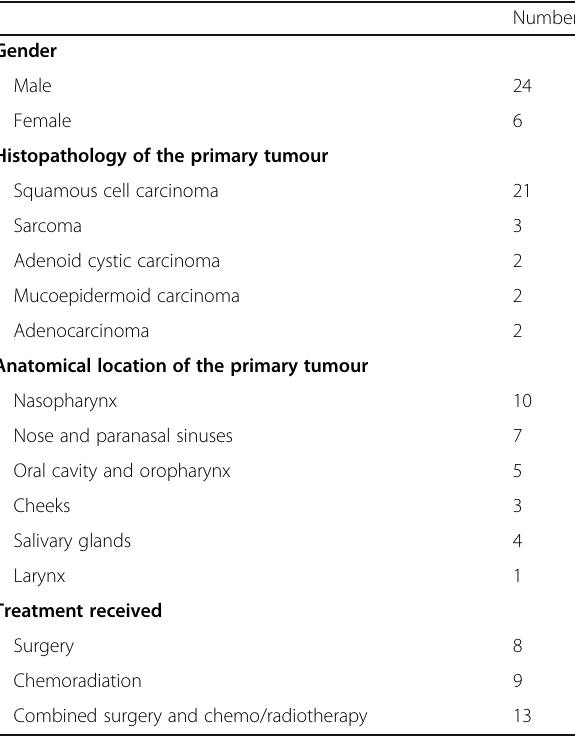
Table 1 Description of the study patients ( n =